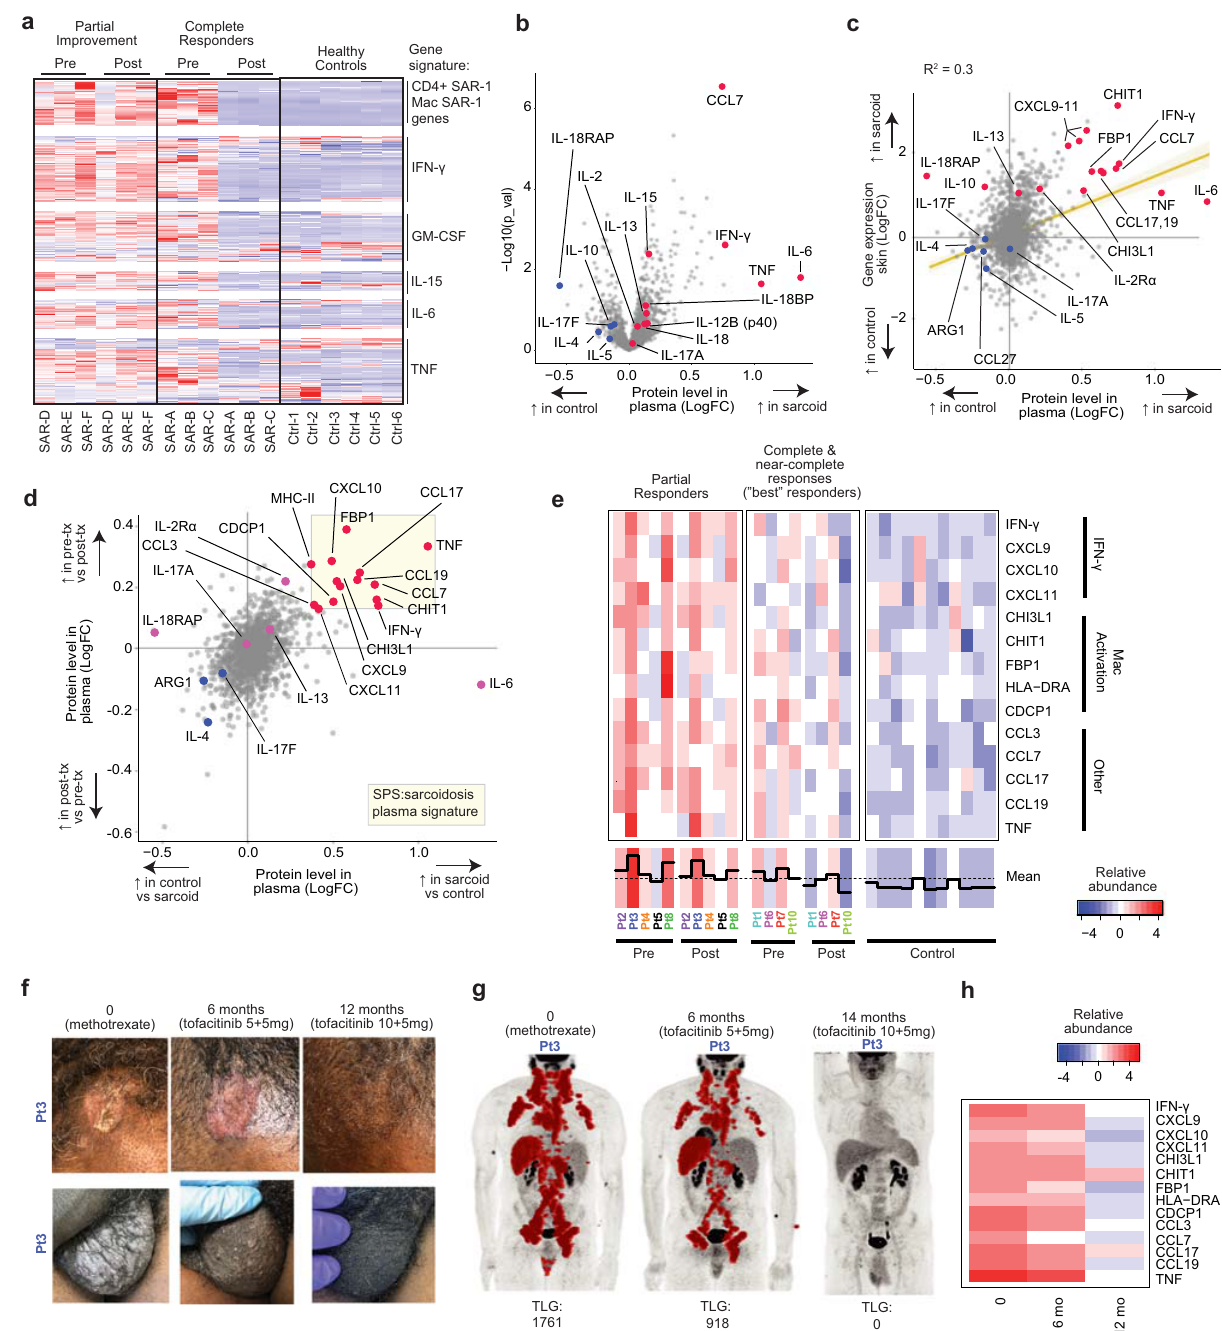
Fig. 9 Tofacitinib reduces cytokine and chemokine levels and markers of macrophage activation in plasma. a Heatmap showing expression of selected transcripts from bulk RNAseq of skin; sample labels are summarized in Supplementary Table 5. b Volcano plot showing relative abundance of proteins in plasma from sarcoidosis patients in this trial compared to healthy controls, p values determined using t-tests, two-tailed. c Relative abundance of plasma proteins in sarcoidosis patients compared to controls (x-axis) compared to mRNA levels in skin of sarcoidosis patients (as determined by bulk-RNA-seq) compared to healthy controls (y-axis). Simple regression line with 95% con fi dence interval (shaded area) shown, goodness of fi t calculated with R squared. d Relative abundance of proteins in plasma of sarcoidosis patients compared to healthy controls (x-axis) plotted against relative abundance of proteins in plasma of sarcoidosis patients at baseline (pre-tx) compared to after 6 months of tofacitinib (post-tx) (y-axis). The most consistently and highly differentially abundant proteins were used to create the sarcoidosis plasma signature (SPS) shown in the shaded box. e Heatmap showing plasma levels of SPS proteins in trial participants (before and after tofacitinib) and healthy controls, grouped by response pattern. Best responders include patients with a complete response in the skin (CSAMI 0 on treatment) and a complete or near complete response in other organs (98% or greater reduction in TLG). Partial responders include all other patients. f Clinical photographs of scalp and scrotal (biopsy-proven) sarcoidosis. Shown at baseline, after 6 months of tofacitinib at 5 mg twice daily, and after 12 months of tofacitinib 10 mg in the morning and 5 mg at night. g PET scans of the patient in panel f before tofacitinib, after 6 months at 5 mg twice daily, and after 14 months at 10 mg in the morning and 5 mg at night, TLG: total lesion glycolysis. h SPS levels corresponding to timepoints in (panel f